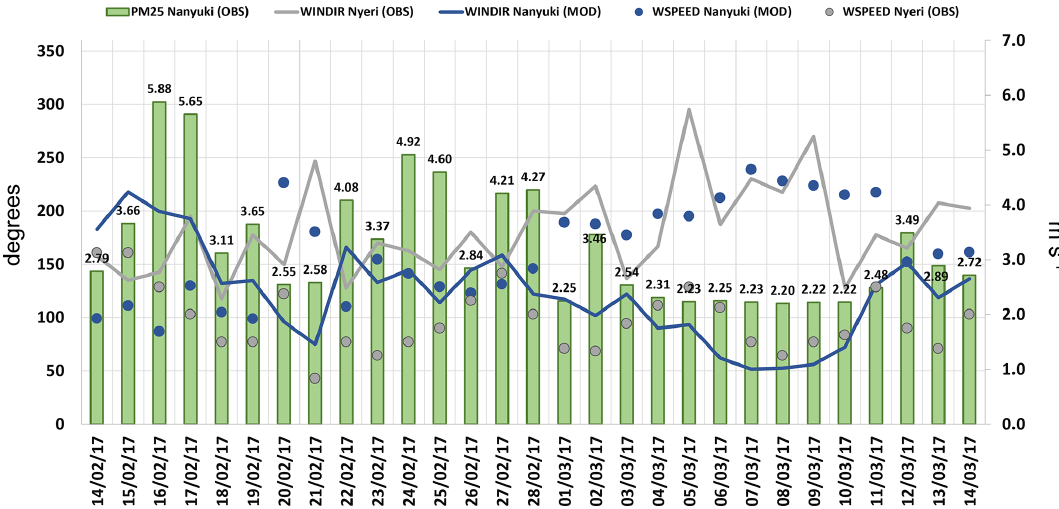
Figure 8. Comparison of daily observed values of wind speed (grey spots) and wind direction (grey lines) from the Nyeri MIDAS site (station no. 10 in Fig. 2c), modelled daily wind speed (blue dots), and wind direction (blue lines) from the Nanyuki site with daily average observations of PM 2 . 5 (expressed inµgm − 3 , green columns) obtained from the sampling site of Nanyuki (upper red dot in Fig. 2c).